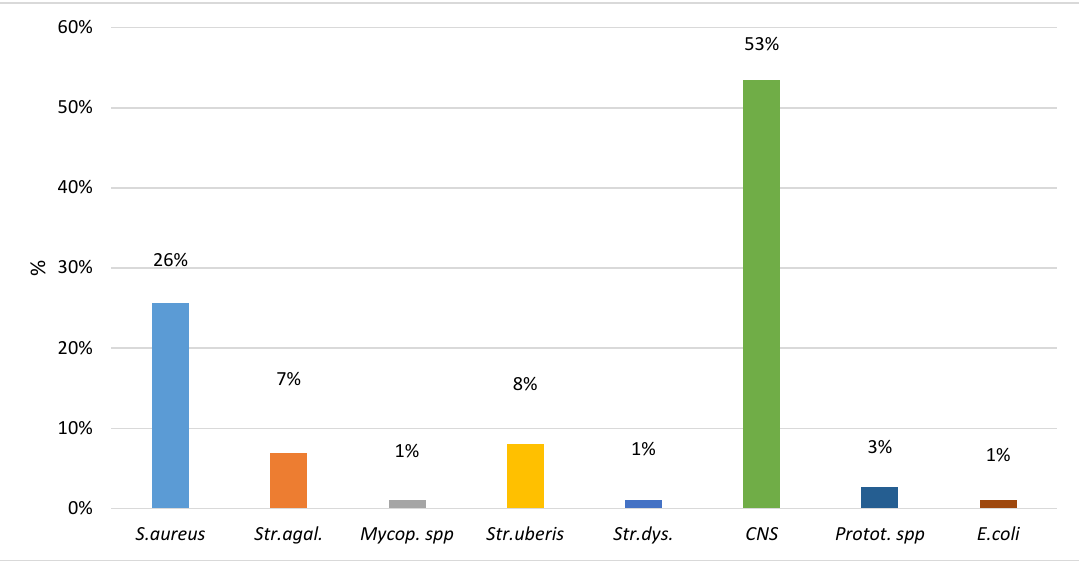
Table 5. Distribution of the microbiological results within the DSCC